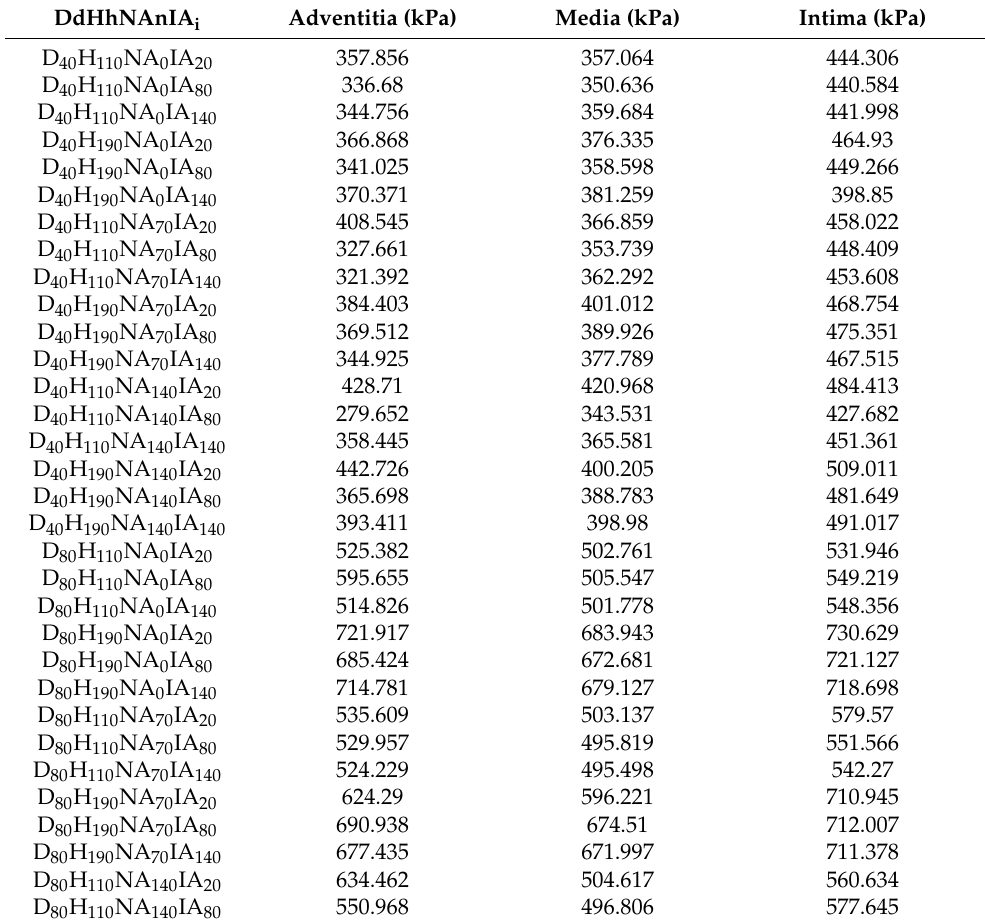
Table A1. PWS measurements in the simulated